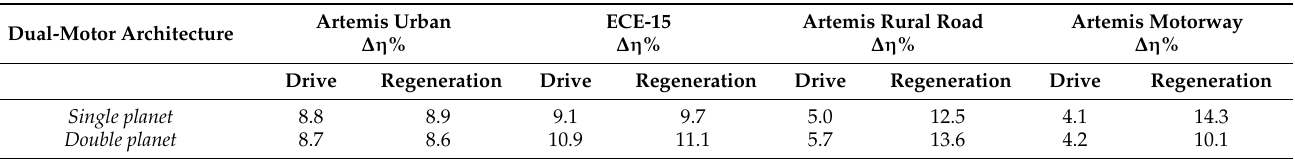
Table 3. Percentage efficiency gain obtained from the proposed dual-motor powertrain compared with standard single- motor transmission for various